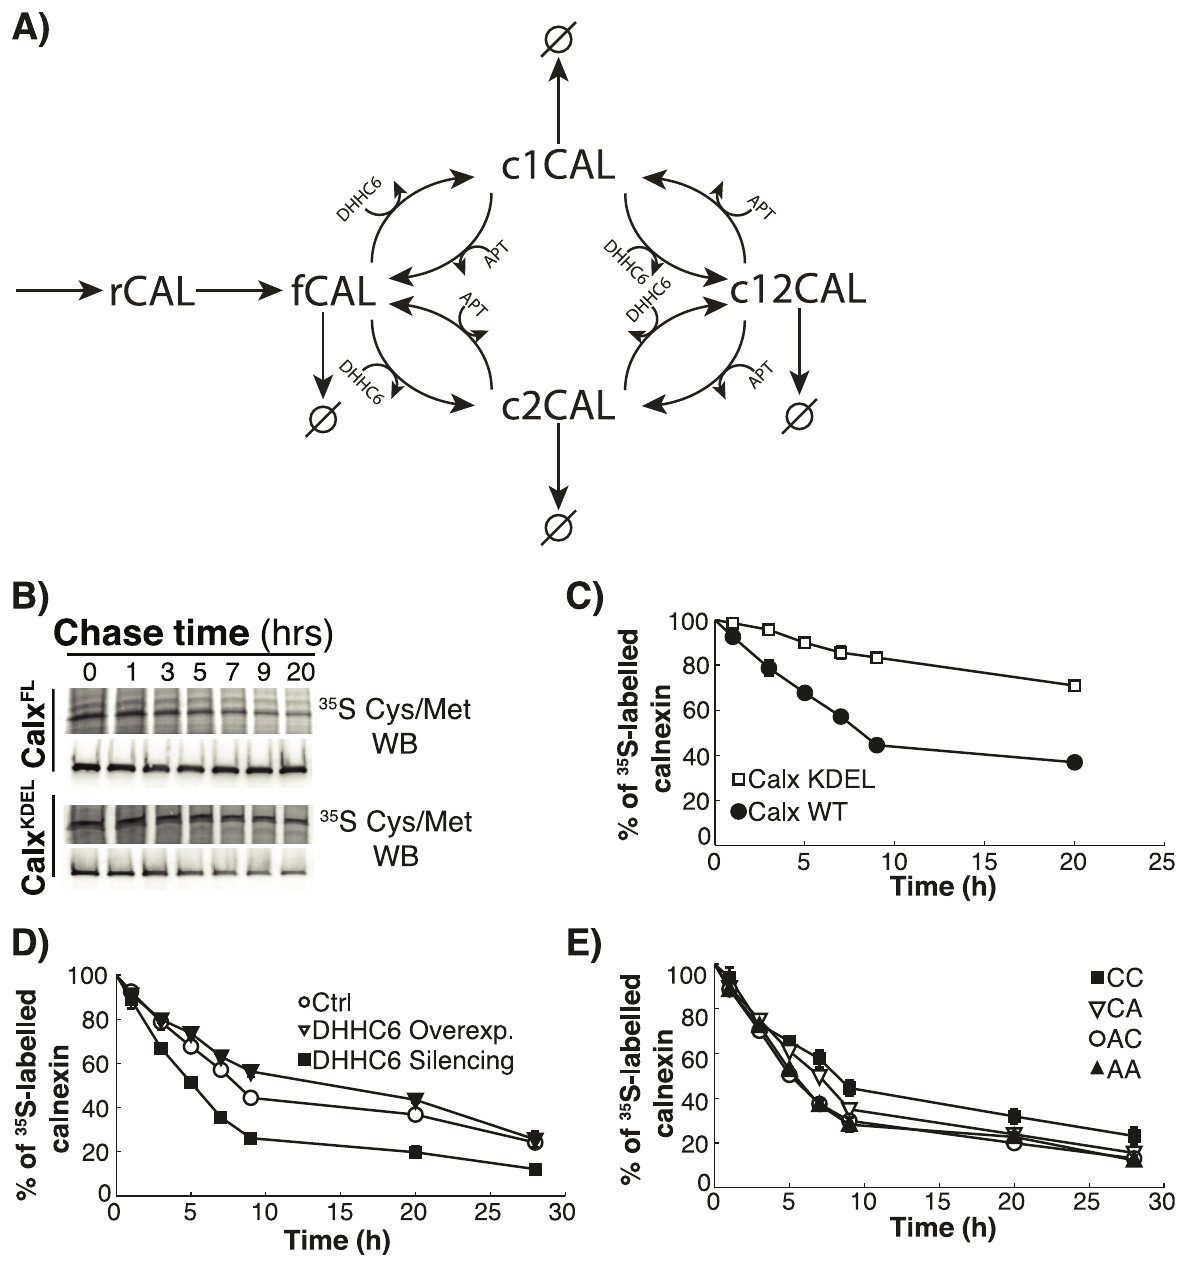
Fig 1. Calnexin palmitoylation model and kinetics of decay. A: Calnexin is first synthesized (rCAL). During the folding process the protein assumes the proper conformation (fCAL), which then can be palmitoylated twice by DHHC6. The first palmitoylation can occur on either of the two sites leading to c1CAL or c2CAL. The second palmitoylation events leads to c12CAL. We assume that both palmitoylation steps are reversible. Degradation can occur from all states. B-E: HeLa cells were transfected or not for 24h with calnexin-WT-HA, HA-calnexin-KDEL, calnexin-CA-HA, calnexin-AC-HA, calnexin-AA-HA and with or without DHHC6-myc, or additional transfected for 72h with DHHC6 siRNA. Cells were incubated 20 min pulse at 37°C with 35 S-methionine/cysteine, washed and further incubated for different times at 37°C. Calnexin was immunoprecipitated and analyzed by SDS-PAGE. Autoradiography (B) and western blotting were quantified using the Typhoon Imager (Image QuantTool, GE healthcare). C: Decay profile of WT calnexin (Calx-WT) and of a calnexin mutant in which the transmembrane and cytosolic domain were removed and replaced by the KDEL sequence for ER retention (Calx-KDEL). Errors correspond to standard deviations (n = 7 for Calx-WT, n = 3 for Calx-KDEL). D: Decay profile of WT calnexin was observed under normal condition (Ctrl) and after overexpression (DHHC6 Overexpression) or silencing (DHHC6 Silencing) of DHHC6. Errors correspond to standard deviations (n = 7, 3, 3 for Crtl, DHHC6 overexpression and silencing respectively). E: Decay profile of WT calnexin (Calx-WT) and different mutants, in which site c1 (Calx-AC), site c2 (Calx-CA), or both palmitoylation sites (Calx-AA) were mutated. Errors correspond to standard deviations (n = 8, 3, 3, 3 for Calx-WT, AC, CA and AA respectively).